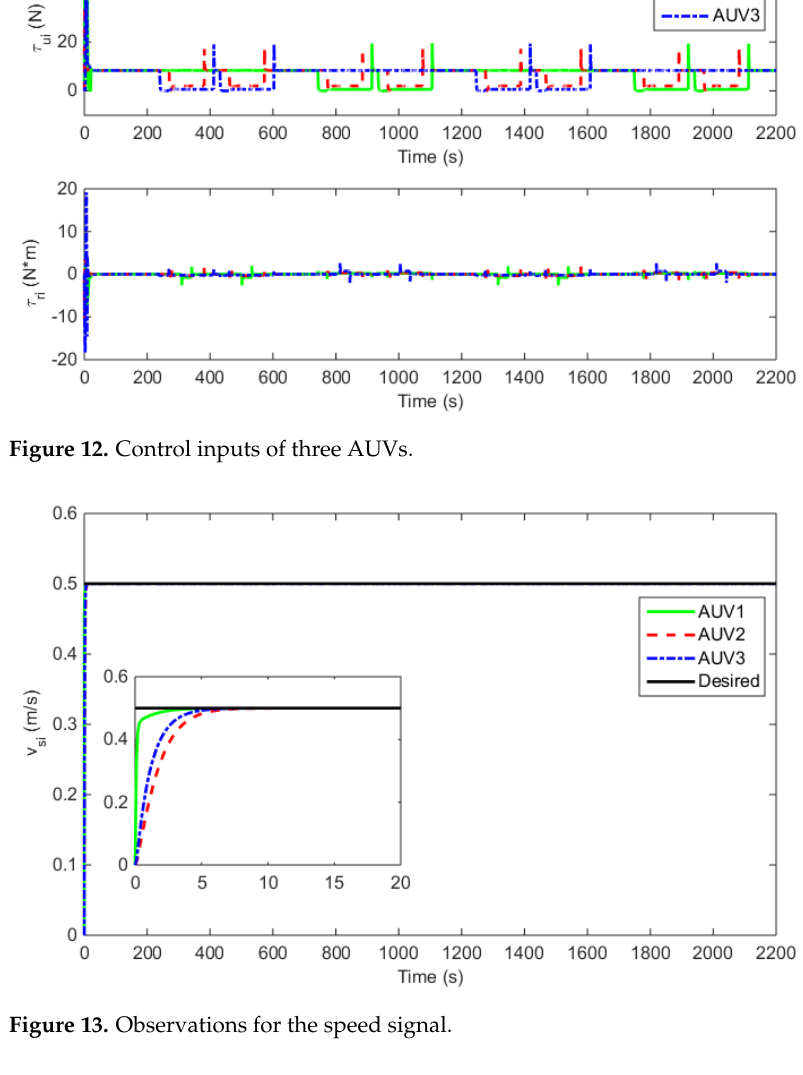
Figure 13. Observations for the speed signal.